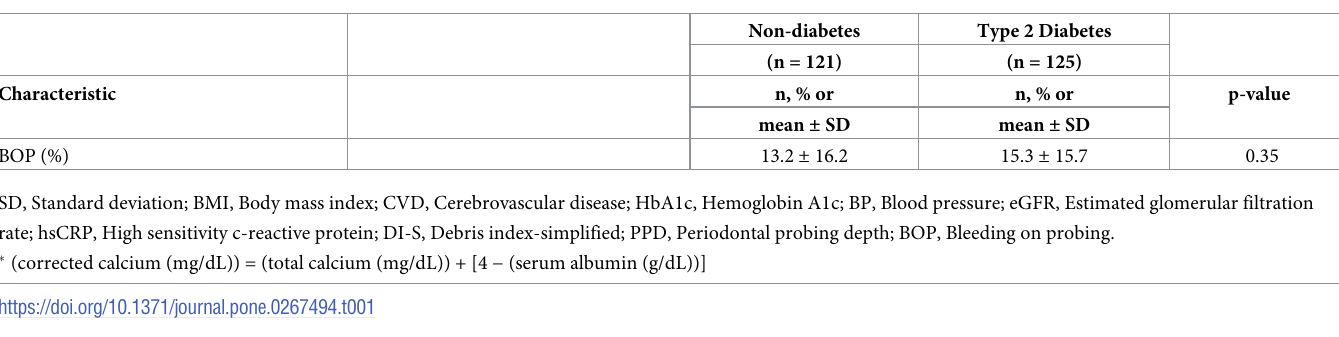
Table 2. Univariate and multivariate ordered logistic regression analysis of the factors influencing the severity of periodontitis in the study patients (n = 246).